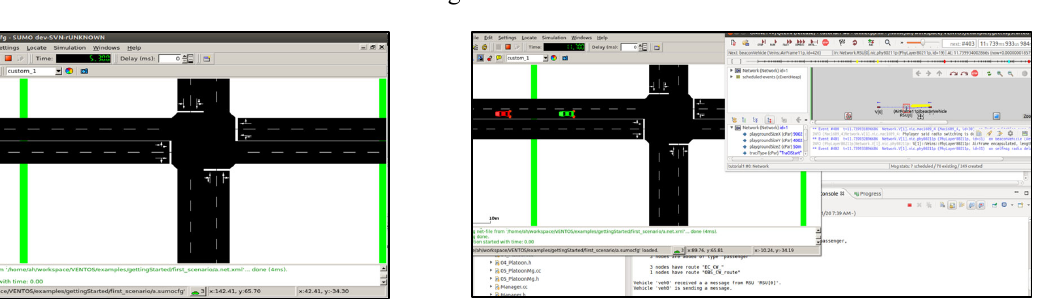
Fig. 7. Scenario1: Vehicle Accident (Obstacle) Occur in Lane 2